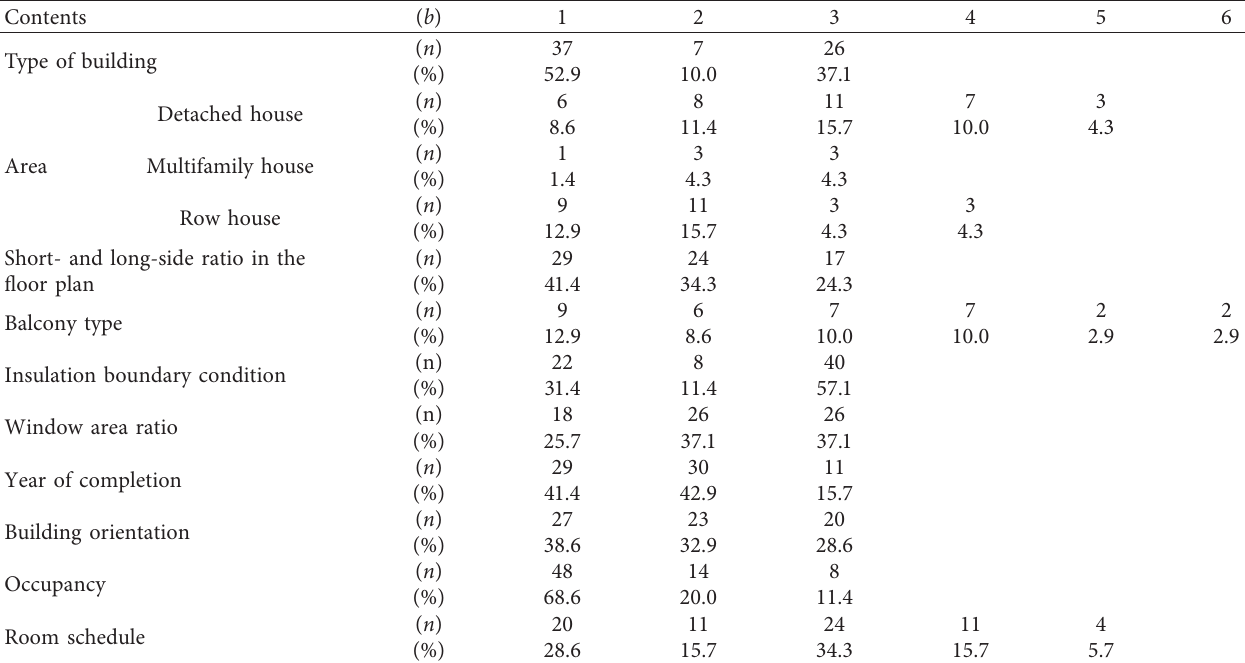
Table 14: Results of survey.